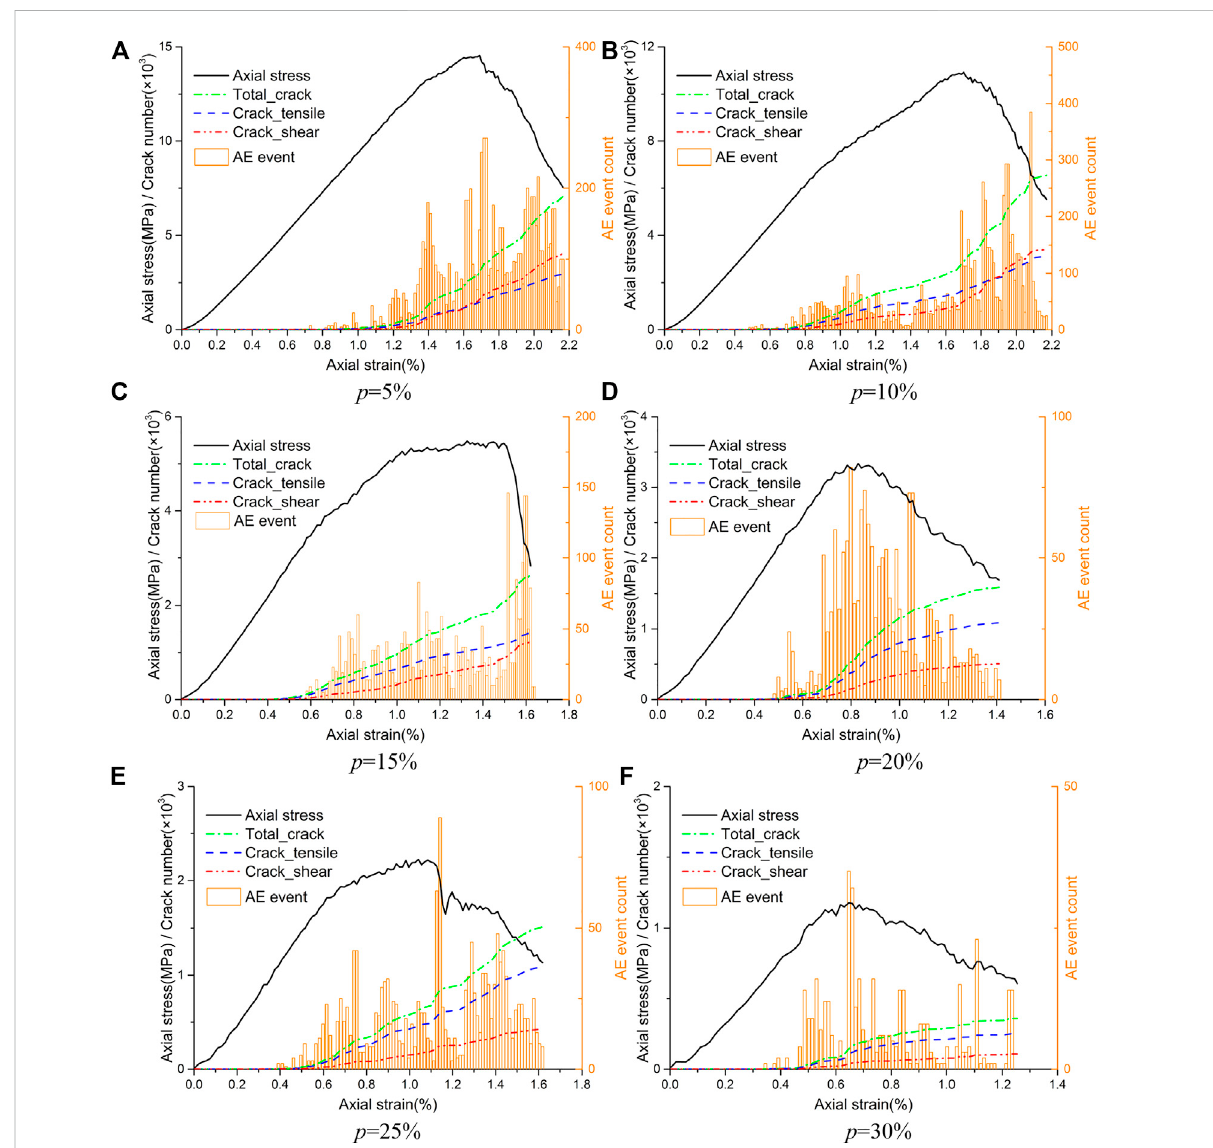
CrackdevelopmentandAEeventcountofthemodelswithincreasingdefectporosity. (A) p =5% (B) p =10%. (C) p =15% (D) p =20%. (E) p =25% (F) p =